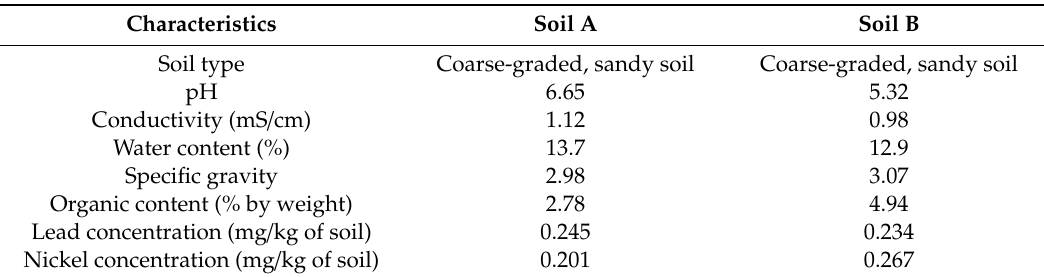
Table 1. Initial characteristics of the soil samples.